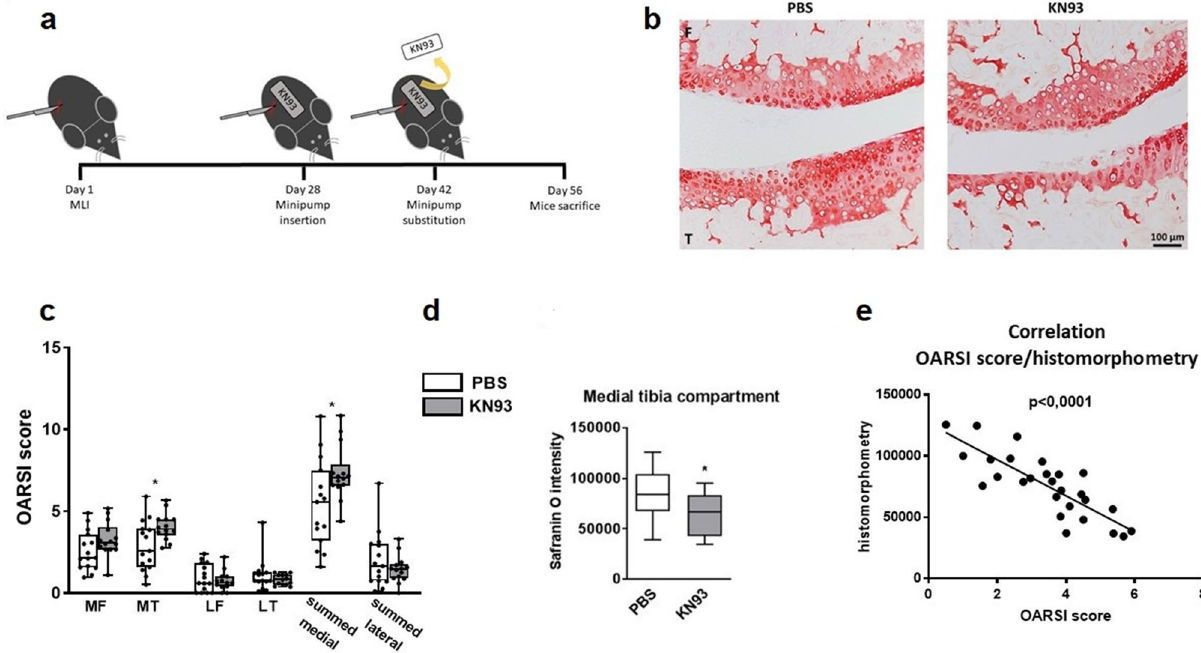
Figure 4. Effect of CaMKII inhibition in vivo in a murine model of OA. ( a ) Osteoarthritis was induced by removal of the anterior horn of the medial meniscus and transection of the medial collateral ligament (MLI model). Four weeks after surgery, mice were administered KN93 or PBS vehicle subcutaneously via a minipump for additional 4 weeks (the initial minipump was replaced after 2 weeks). The total volume administered over 4 weeks was equal to 400 µl. n = 15/treatment. ( b ) Safranin O staining of representative sections of the medial compartment of the knee of mice treated with PBS or KN93. ( c ) OARSI score of the medial and the lateral compartments of the MLI knees n = 15/treatment. ( d ) Histomorphometry analysis of the MLI knees. ( e ) Correlation of the OARSI score and histomorphometry analysis. MF: medial femur; MT: medial tibia; LF: lateral femur; LT: lateral tibia. OARSI scores were analysed with Mann–Whitney test with Wilcoxon post-test. Histomorphometry data were analysed by t-test. Linear regression was used to compare the OARSI scores and histomorphometry